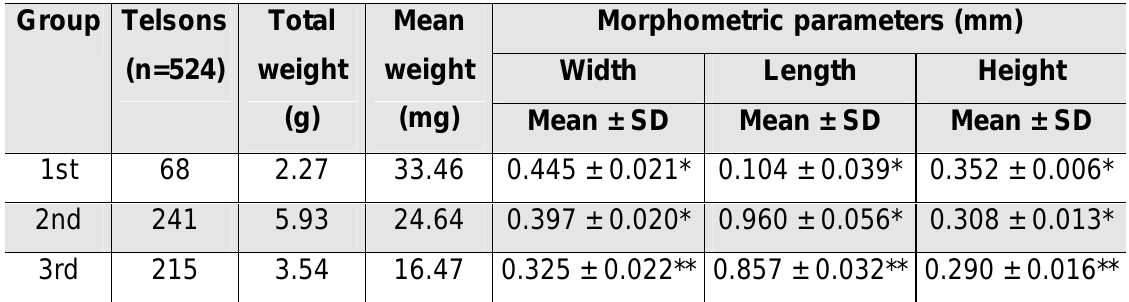
Table 1: Groups of telsons and their morphometric characteristics. There were not statistically significant differences according to weight and morphometric parameters ( p